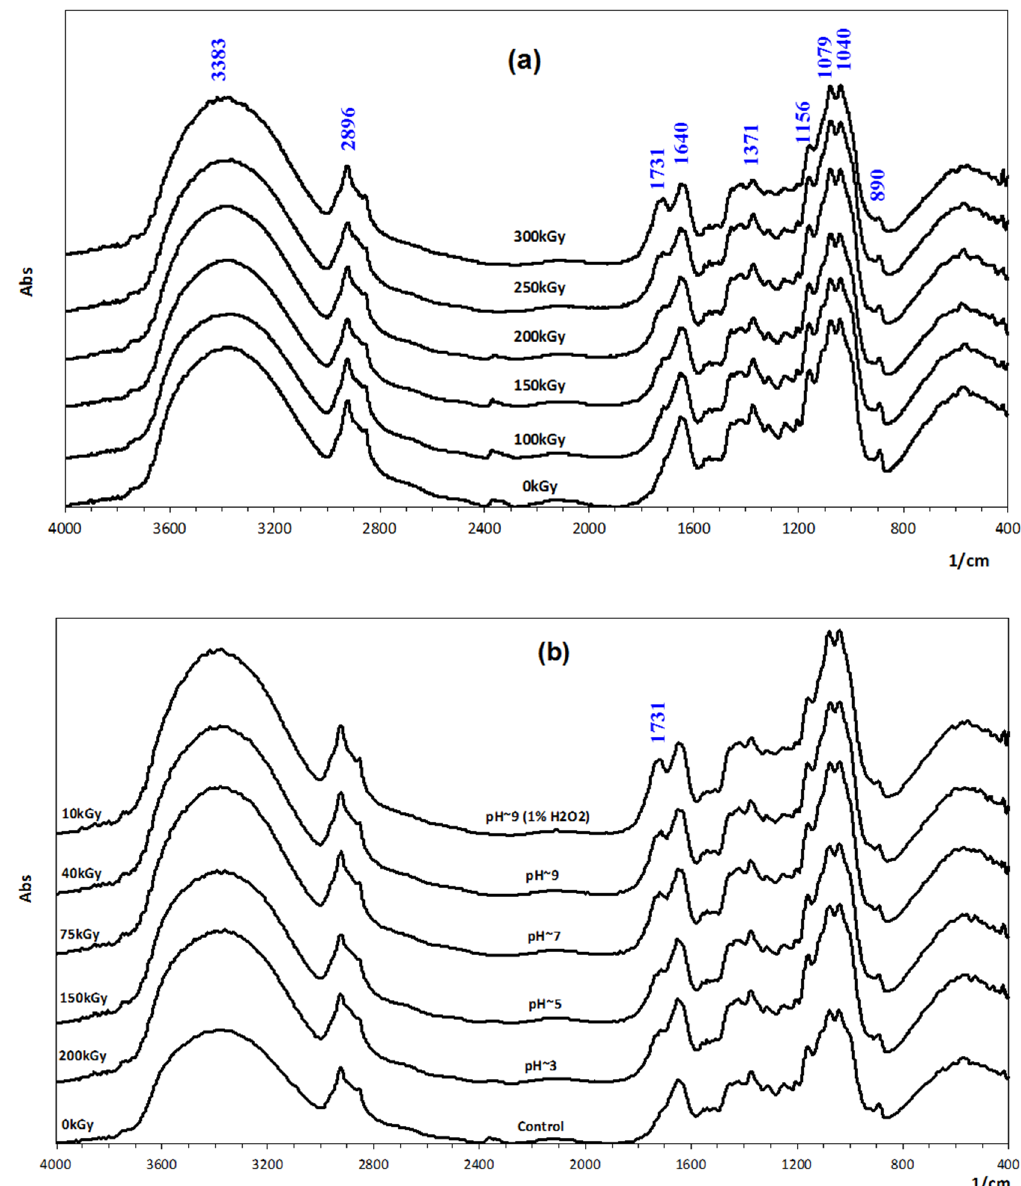
Figure 3. The Fourier transform infrared (FTIR) spectra of β -glucan samples irradiated at different doses ( a ) and in various pH conditions, with and without the present of H 2 O 2 ( b ).